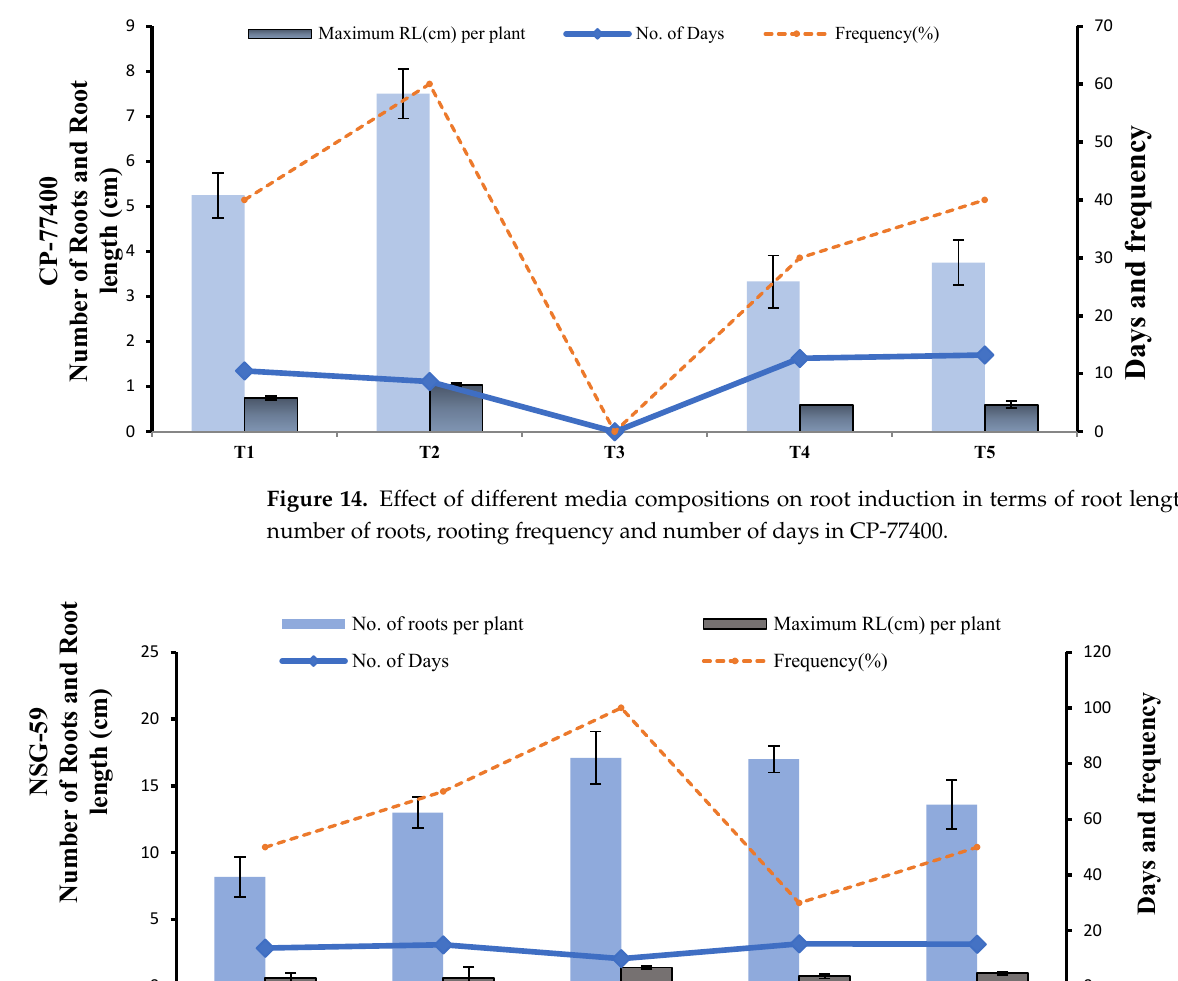
Figure 15. Effect of different media compositions on root induction in terms of root length (cm), number of roots, rooting frequency and number of days in NSG-59.